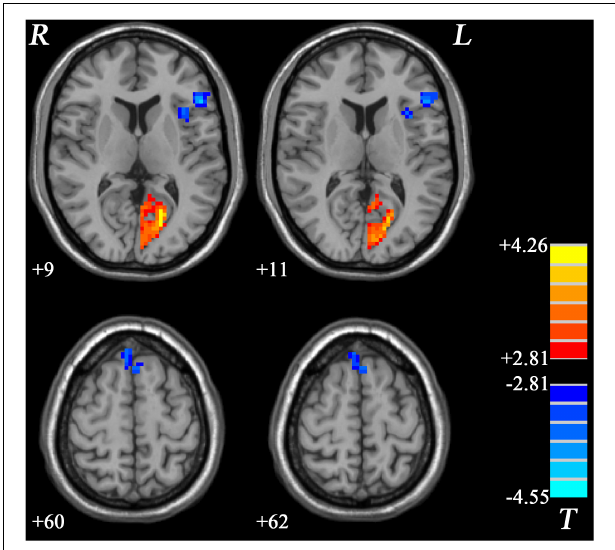
FIGURE 4 | Regions with significantly different PAS scores in nGI-MDD patients compared to HCs. The color bar indicates the T -values from post hoc t -tests. HCs, healthy controls; nGI-MDD, major depressive disorder without gastrointestinal symptoms; PAS, parameter of asymmetry.